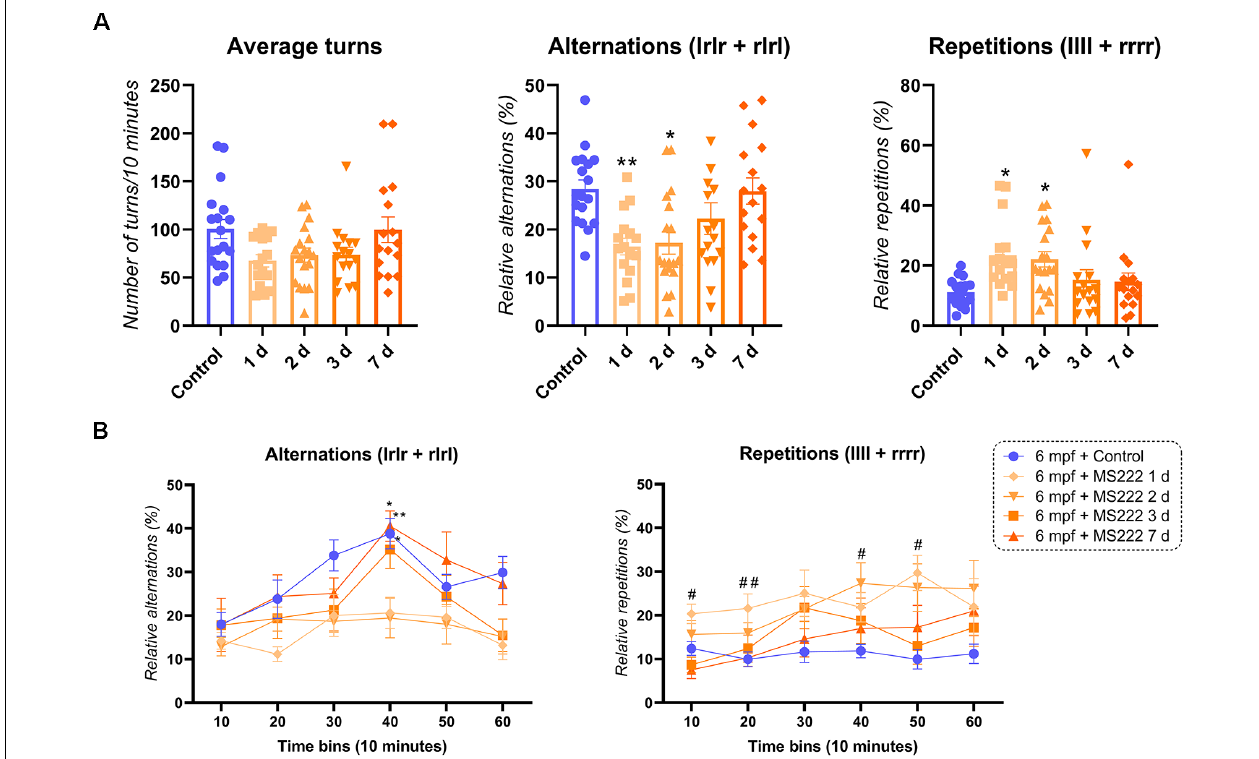
FIGURE 1 | FMP Y -maze response of 6 months post-fertilization (mpf) animals 1, 2, 3, or 7 days after exposure to MS222. (A) Overall behavioral patterns/10 min. (B) Alternations and repetitions across time for 6 mpf controls vs. 1 day vs. 2 days vs. 3 days vs. 7 days after MS222 exposure. Asterisk represents differences across time within groups ( p * < 0.05; p ** < 0.005) and octothorp represents differences between groups at a specific time bin ( p # < 0.05; p ## < 0.005). Data were represented as mean ± S.E.M and analyzed by one-way ANOVA or two-way repeated measures ANOVA, followed by Tukey’s test multiple comparison test ( n = 16–18 per